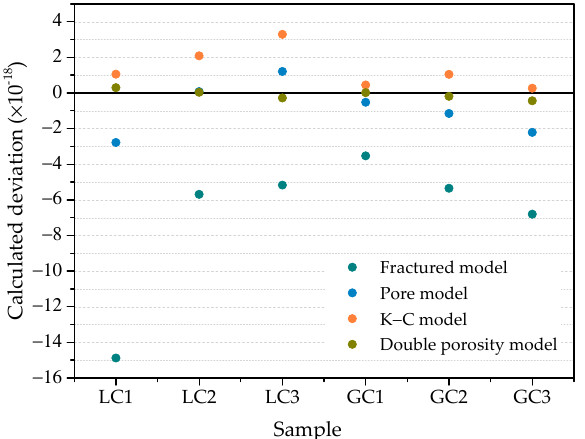
Figure 15. Comparison of calculated deviation results.